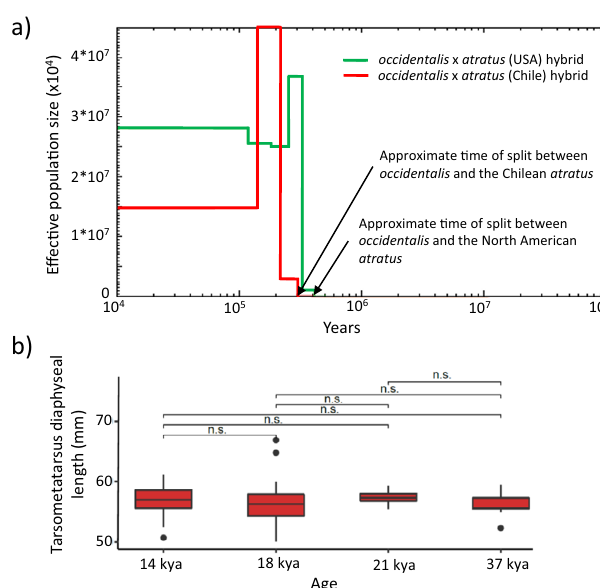
Fig. 3 Dating of the split between Coragyps atratus and occidentalis , and osteometric support for morphological stasis in occidentalis during the Late Pleistocene. a hPSMC plot based on the arti fi cial F1 hybrid genomes constructed using the fossil occidentalis together with (red) an atratus individual collected in Chile (CA73) and (green) an atratus individual collected in USA (CA03). The time when the hybrid genome indicates an extreme increase in effective population size is inferred to mark the cessation of gene fl ow between the populations from which the two haploid genomes derive. The hPSMC curves suggest that the ancestors of occidentalis the atratus population in Chile (the one that is phylogenetically closest to occidentalis ) diverged sometime before 300 kya, while the split between the ancestors of occidentalis and the atratus population in the USA seems to have occurred c. 100 kya earlier. b Box-plots of tarsometarsi diaphyseal lengths from occidentalis fossils collected in different tar pits at La Brea, California, indicate that the size of occidentalis has remained constant, despite the dramatic climatic and environmental changes at the end of the